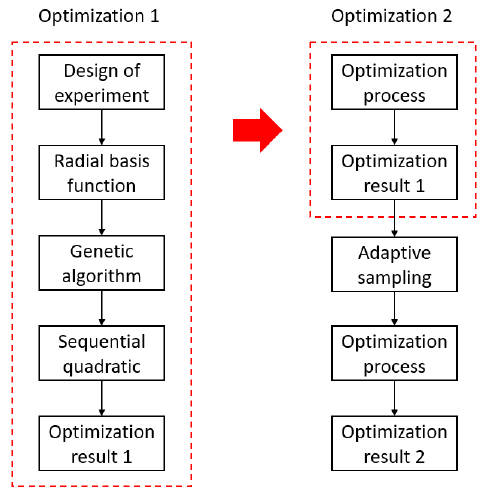
Figure 2. Flowchart of mooring anchor chain optimization based on an approximation model.